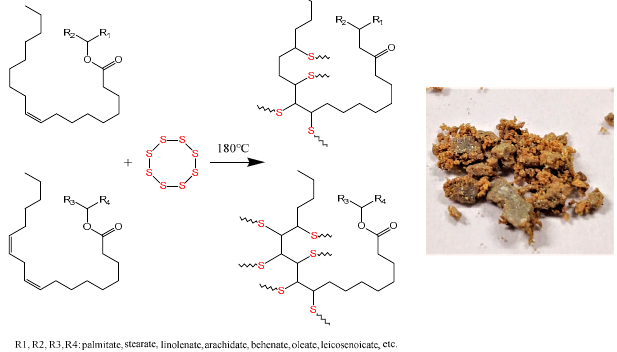
Figure 3. The reaction formula of poly (sulfur-peanut oil) (poly(S-P)) copolymer and the product photograph.